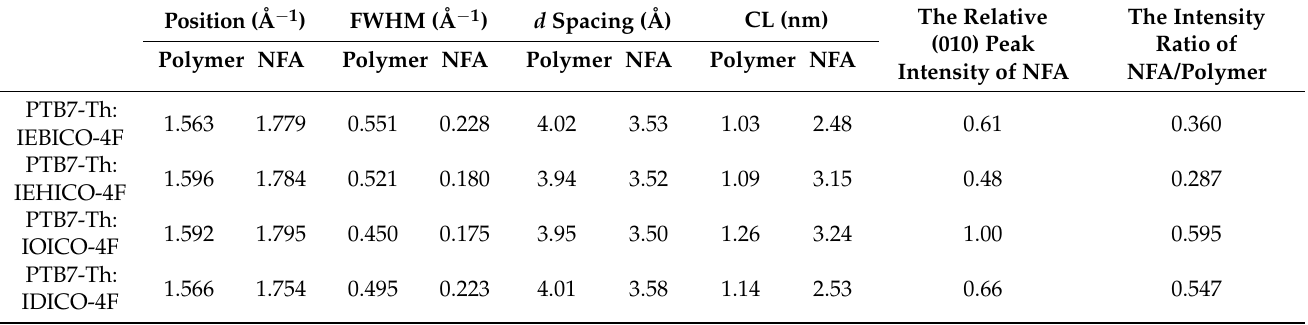
Table 4. Characteristics of (010) peaks in the out-of-plane direction for PTB7-Th:IRICO-4F blend